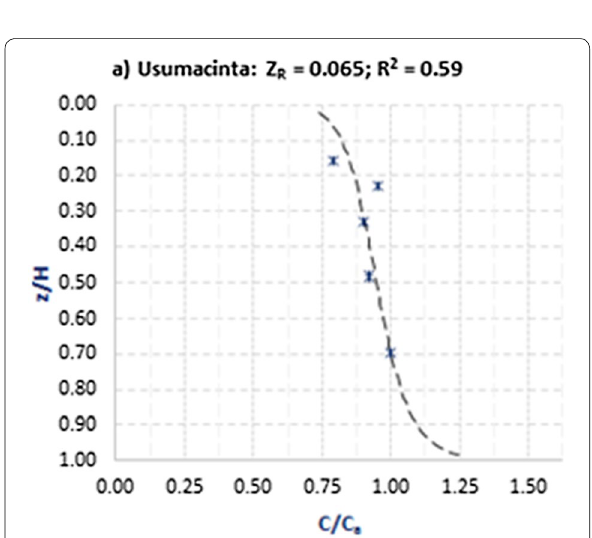
Fig. 6 Suspended sediment concentration profile for the Usumacinta river